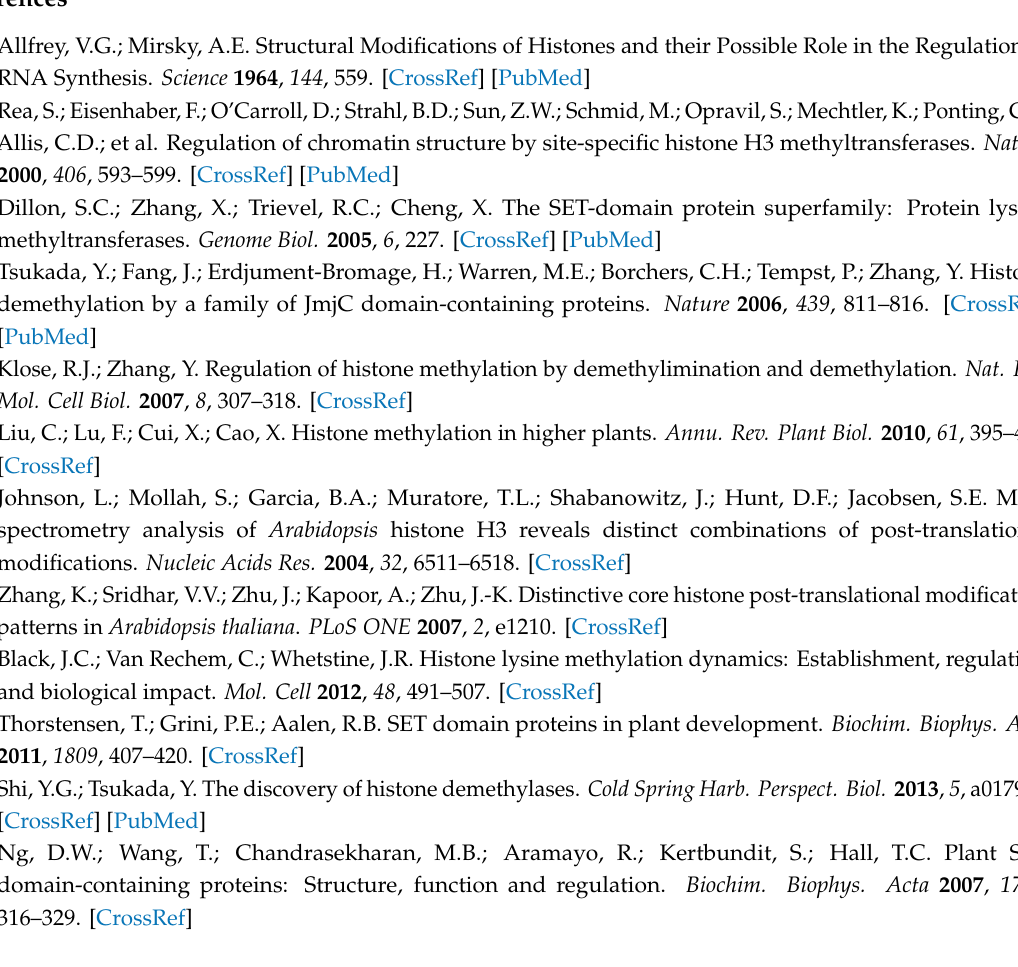
motif. Figure S4: The consensus sequence of conserved motifs of JmjC and predicted length (amino acids) for each motif. Figure S5: Chromosome locations of SET were obtained from the GFF file and displayed using Mapchart. The paralogous pairs are displayed in red. The paralogous pairs are displayed in red and while the three subgenomes (i.e., LF = Least fractionated, MF1 = Medium fractionated and MF2 = Most fractionated genome) of Brassica rapa are also visualized by di ff erent color. The ancestral karyotypes (i.e., AK1–AK7) are marked in di ff erent colors and the letters inside the circles represent the block positioned in the genome of Brassica rapa . Figure S6: Venn diagram analysis of the tissue-expression of SET (A) and JmjC (B), Figure S7. (A) Heat map of expression profiles (log 2 fold-change) for 17 SET and JmjC paralogous pairs in six various tissues: silique, stem, root, flower, leaf, and callus. The Pearson correlation coe ffi cients (PCCs) are also displayed in brackets, while NA indicates no available results for PCC. (B) Venn diagram analysis of the tissue-expression of paralogous pairs for both SET and JmjC. Table S1: The basic description of SET and JmjC genes in Brassica rapa , Table S2: Identification of SET and JmjC syntenic genes between A. thaliana along with three subgenomes of Brassica rapa , Table S3: Ka / Ks calculation of the paralog pairs of SET and JmjC in Brassica rapa , Table S4: The FPKM values of SET and JmjC genes in Brassica rapa , Table S5: Syntenic paralog pairs of SET and JmjC with PC and FPKM values, Table S6: Cis-elements of SET and JmjC genes in Brassica rapa , Table S7: Sequences of SET and JmjC gene primers used for quantitative real-time